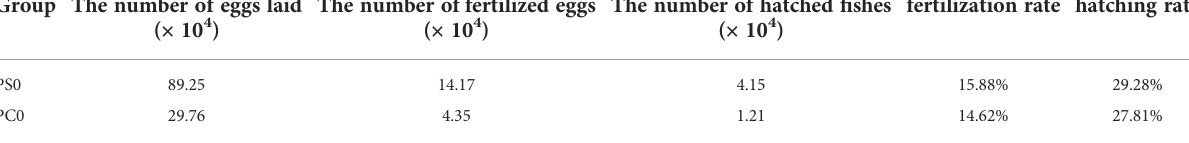
TABLE 2 The egg-laying information summary of Pampus argenteus from the selected group and control group. Group The number of eggs laid (× 10 4